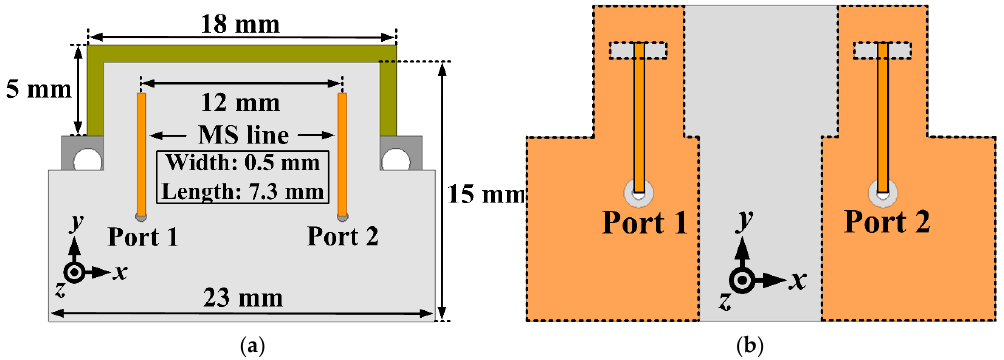
Figure 2. Feed circuit of slot-type Doppler radar antenna: ( a ) designed microstrip-line on Rogers RO4350B superstrate; ( b ) perspective view of microstrip-line and slotted aperture.